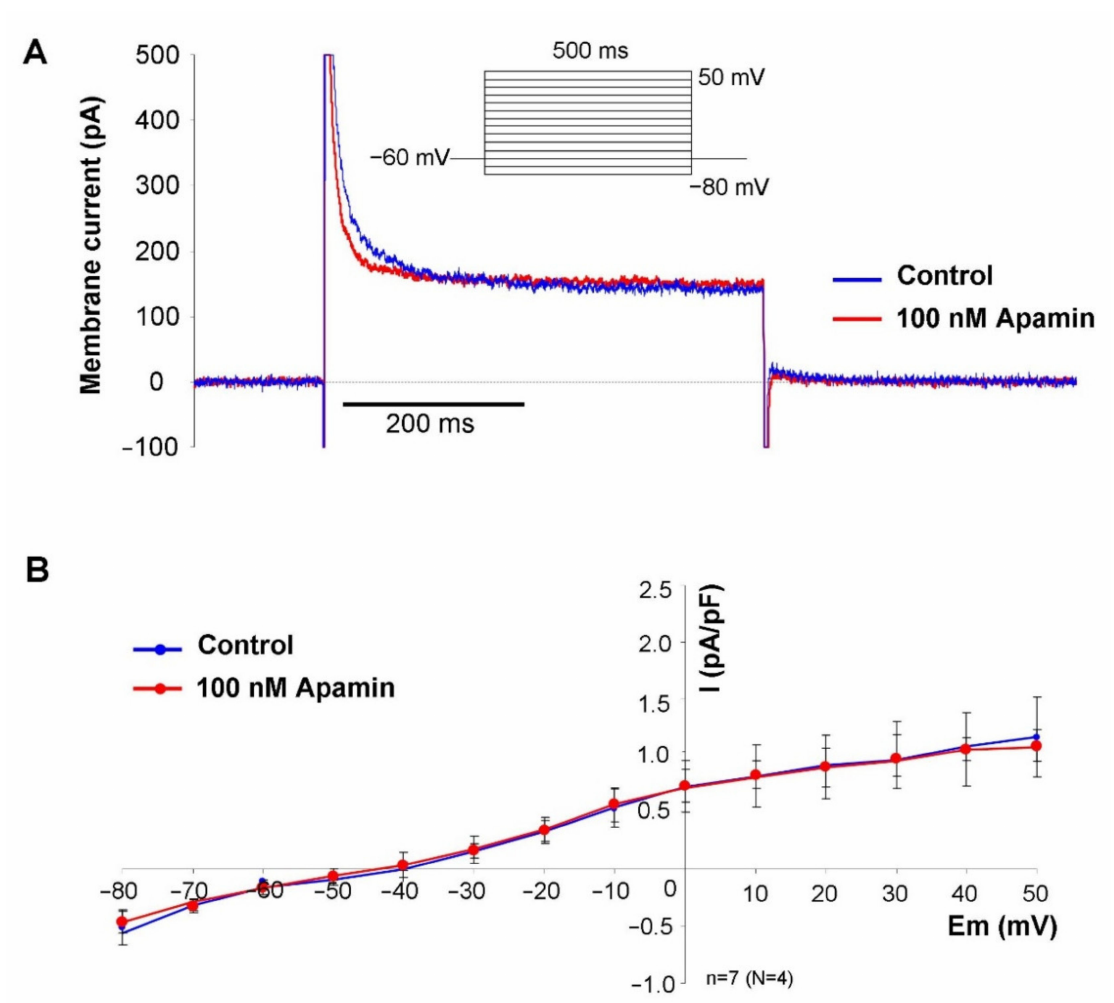
Figure 3. Characterization of the apamin-sensitive current. For further validation, the intracellular solution was heavily buffered with 10 mM BAPTA. Under this condition, the apamin failed to dis- sect any current from the control recording. ( A ) shows representative current traces under control condition (blue curve) and in the presence of 100 nM apamin (red curve) at 20 mV voltage pulse. ( B ) shows the current-voltage diagram where control and apamin resulted in identical curves. Statis- tical analysis was performed by paired t